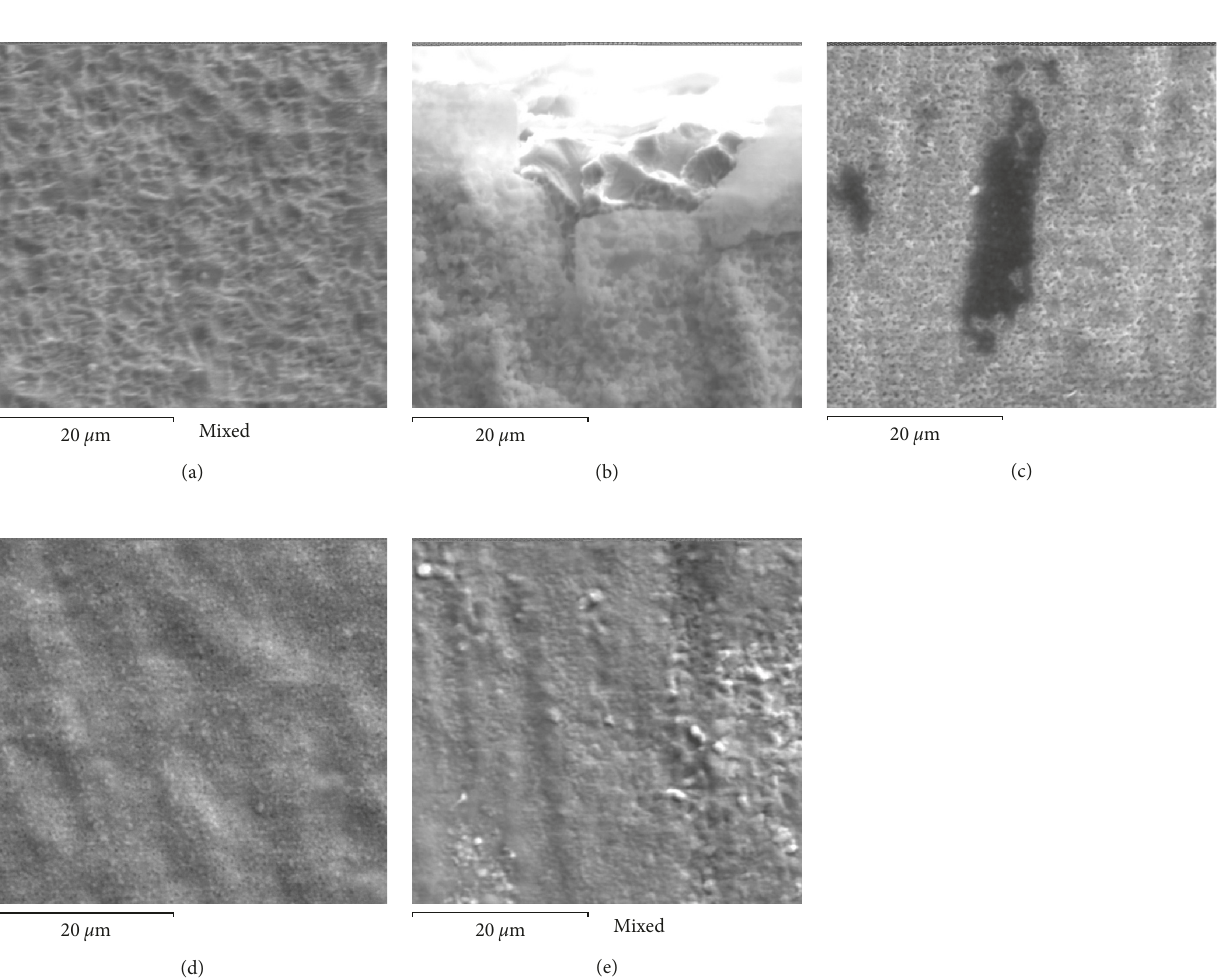
3 Al, (b)Ni 3 Al+1.0% Ag, (c) Ni 3 Al +1.0%